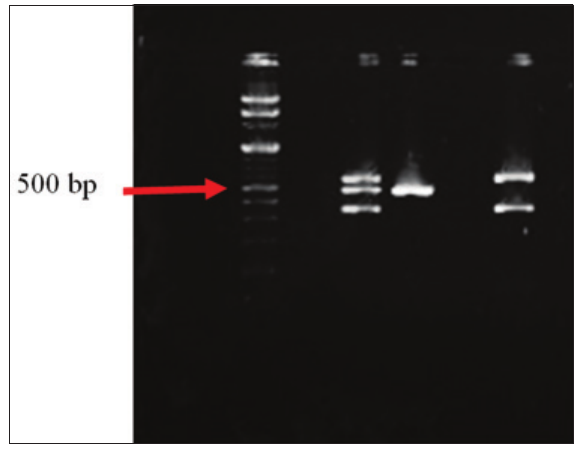
Figure-1: Gel electrophoresis picture of multiplex polymerase chain reaction of Shiga toxigenic Escherichia coli . Lane 1= 100 bp DNA ladder (Fermentus) Lane 2= Negative control (NTC) Lane 3= Positive control (548 bp, 482 bp, 348 bp) Lane 4= Test isolate positive for eae (482 bp) Lane 6= Test isolate positive for both stx 1 and stx 2 (348 bp, 584 Table-2: Isolation and molecular characterization of STEC of animal and bird origin.